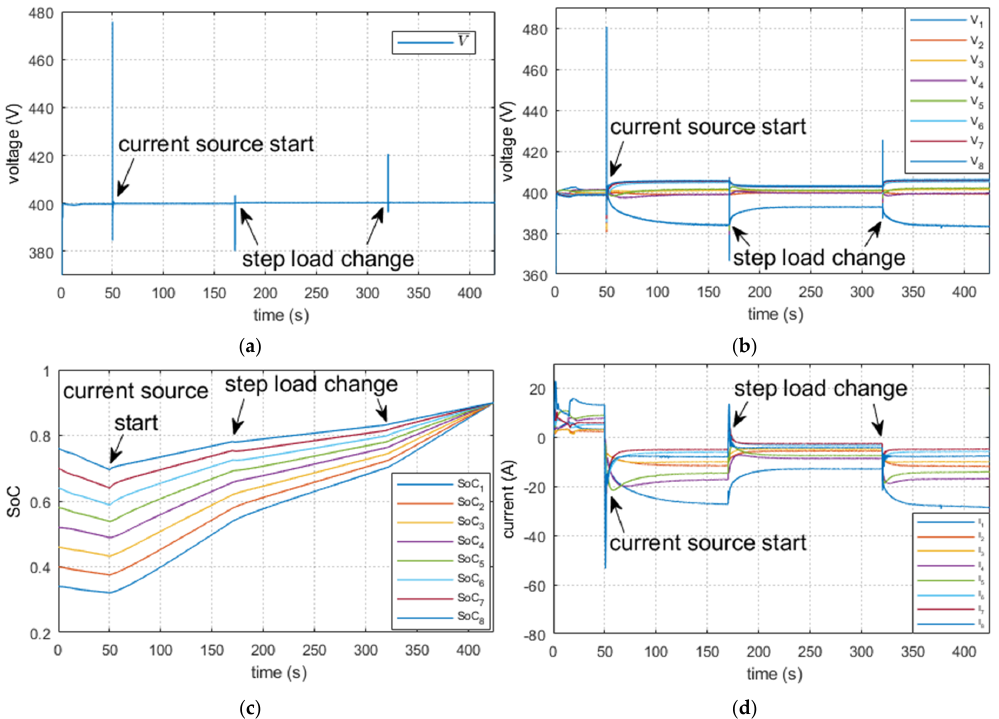
Figure 7. Fast discharging and charging simulation results: ( a ) average voltage; ( b ) dynamic voltages; ( c ) SoCs; ( d ) output currents. Energies 2020 , 13 , x FOR PEER REVIEW